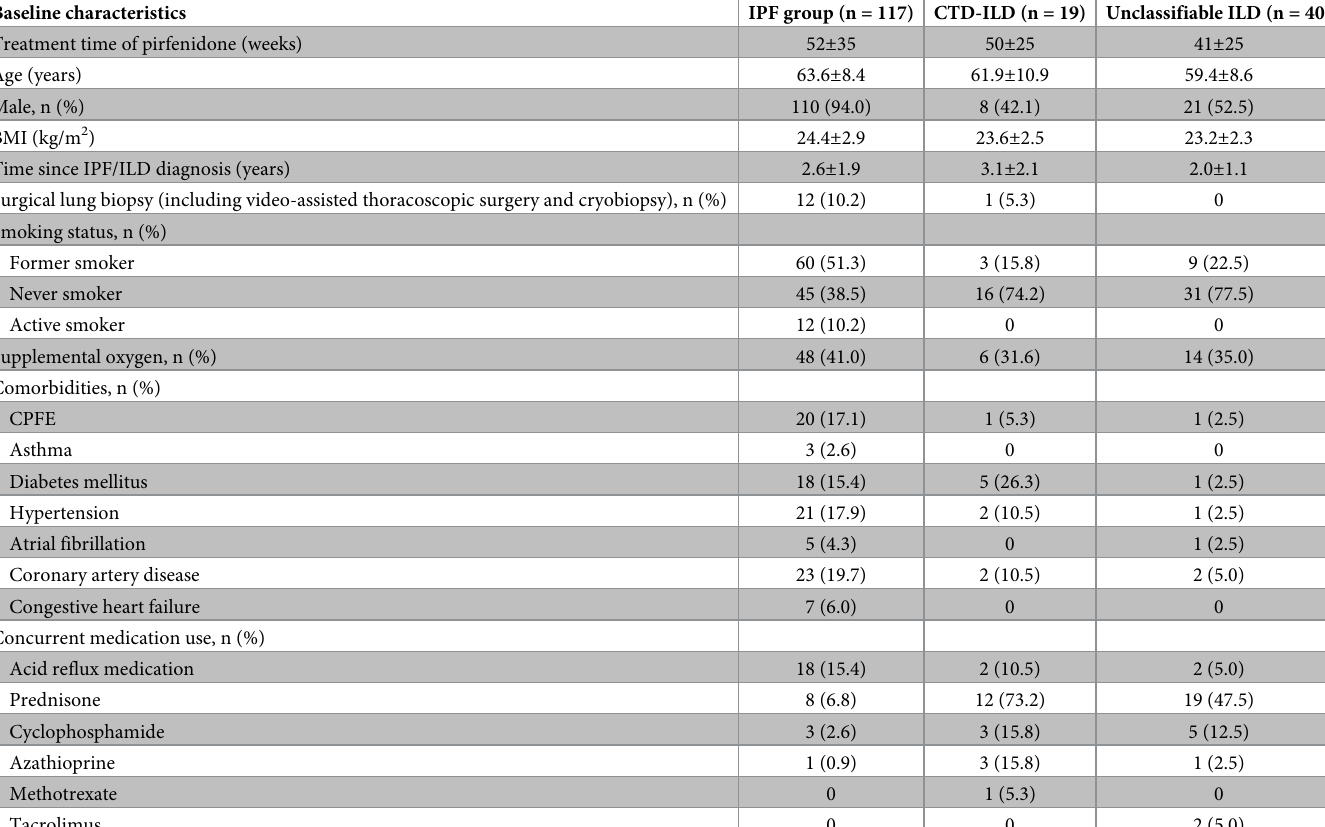
Table 1. Baseline characteristics.